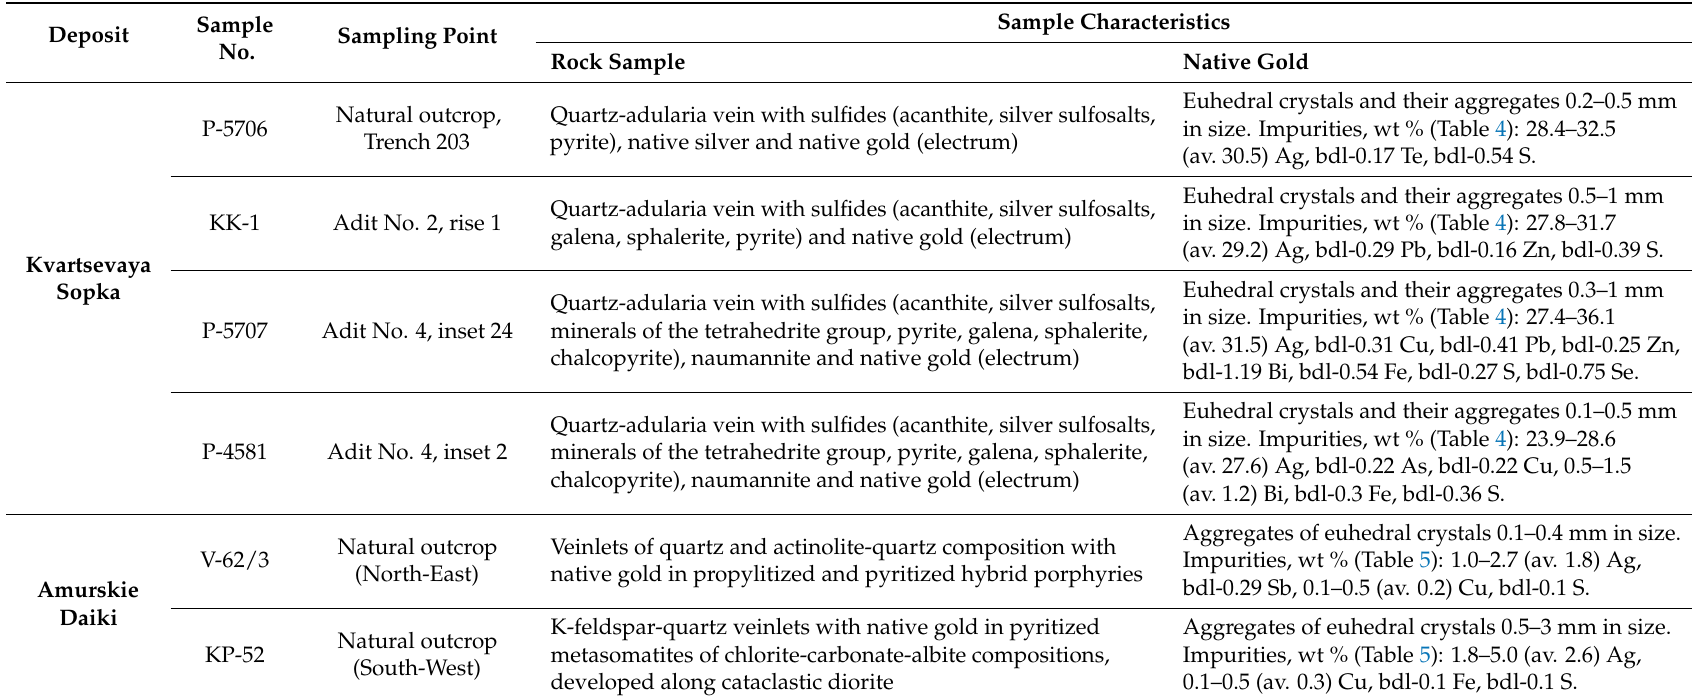
Table 1. Brief description of the samples